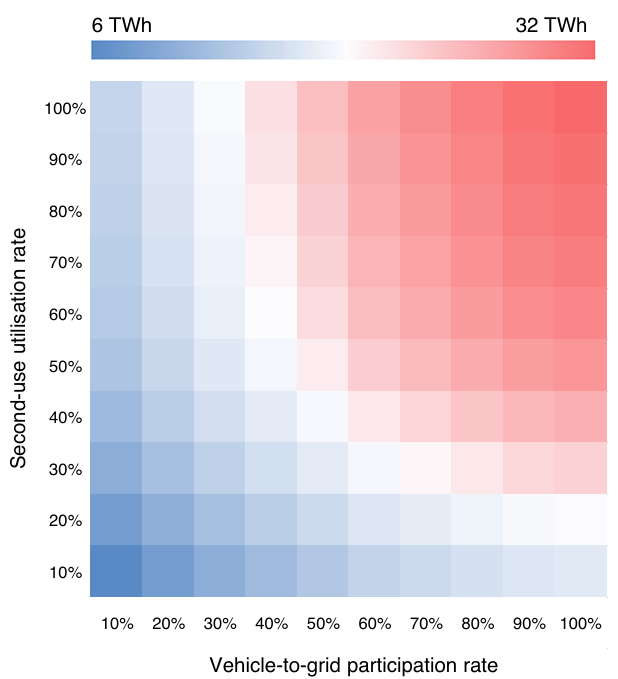
Fig. 5 | Total actual available capacity under various conditions in STEP-NCX scenario in 2050. Blue, white, and red colors depict minimum, average, and maximum values. See Supplementary Figs. 26 – 28 for other